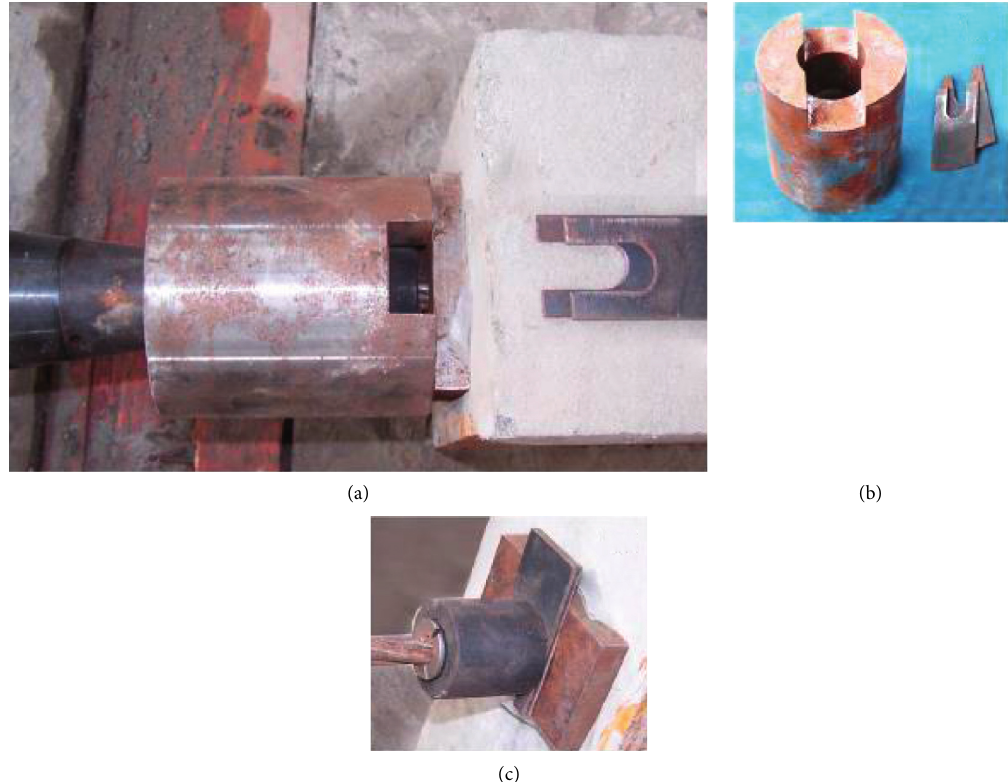
Figure 2: Insert gasket for tension supplement. (a) Insert gasket for tension supplement and (b) brace angle and gasket (c) after tension supplement [15]. Table 3: Tensioning data of prestressed tendons. Specimen